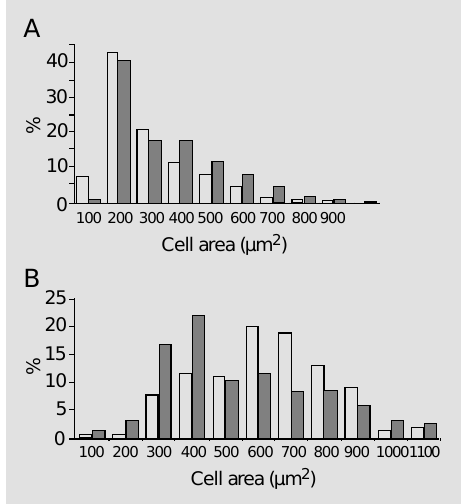
Figure 2 - Effect of high-salt di- etary intake on myenteric neu- ron cell size. Rats received 0.15 (filled bars - low-sodium diet) or 8% (open bars - high-sodium diet) NaCl in their diets for 15 weeks (A) or 52 weeks (B). Data are reported as histograms of neuronal cell profile area for 600 neurons measured in colon tis- sue from 6 rats in each group (chi-square